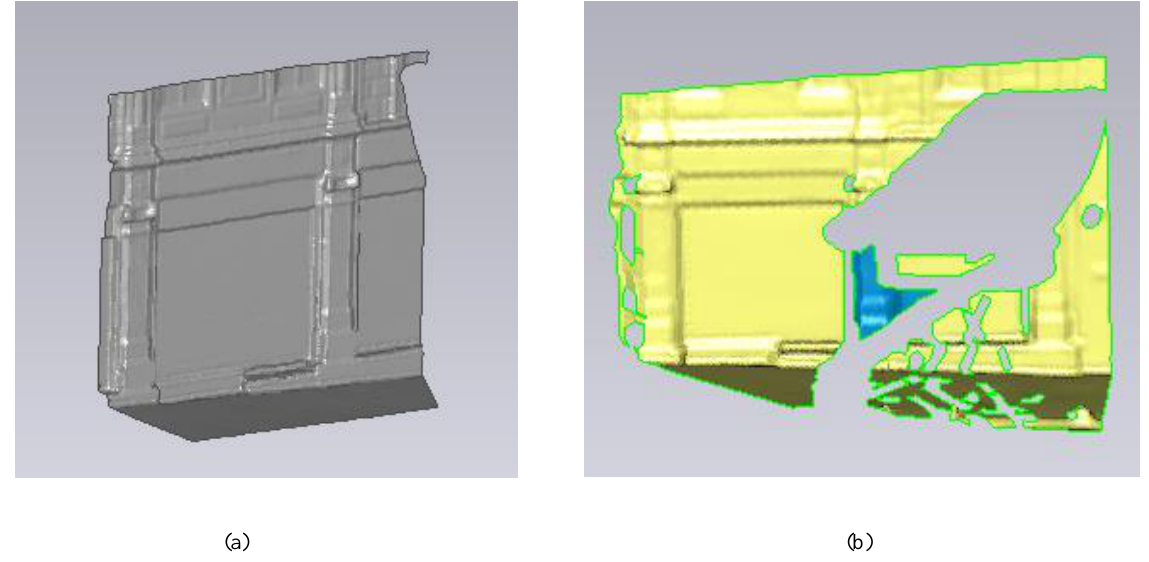
Figure 1. Two overlapping data sets. (a) is the left scan and (b) is the right scan of the facade